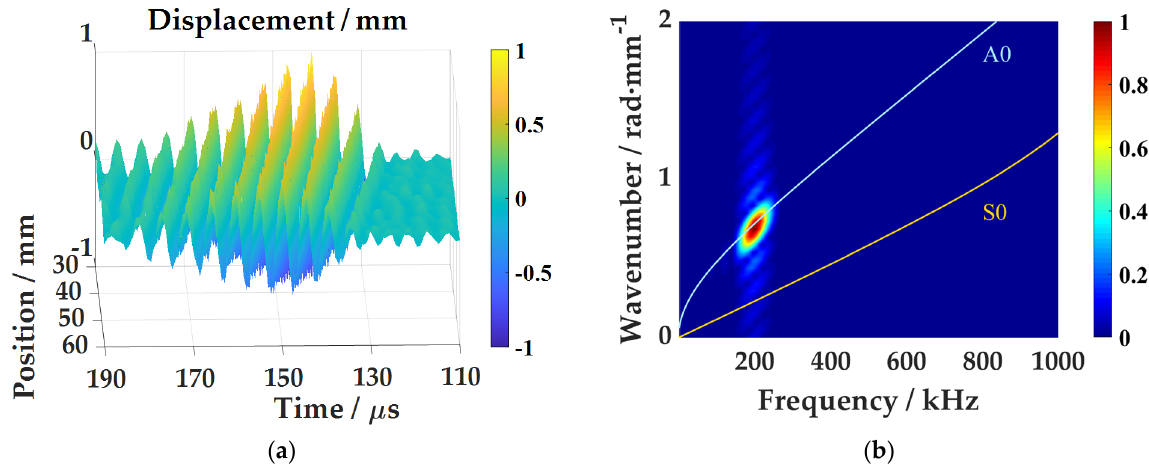
Figure 5. Test results of 2 mm thick aluminum plate: ( a ) Lamb wave one-dimensional time domain wave field; ( b ) Frequency-wavenumber spectrum.